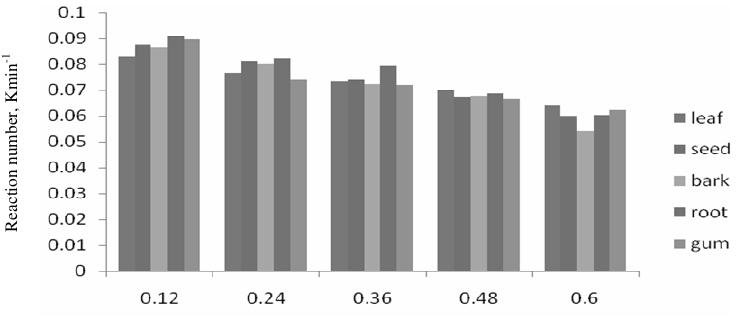
Figure 8. Variation of reaction number vs. Concentration with all five inhibitors in 4 N hydrochloric acid solution in mild steel